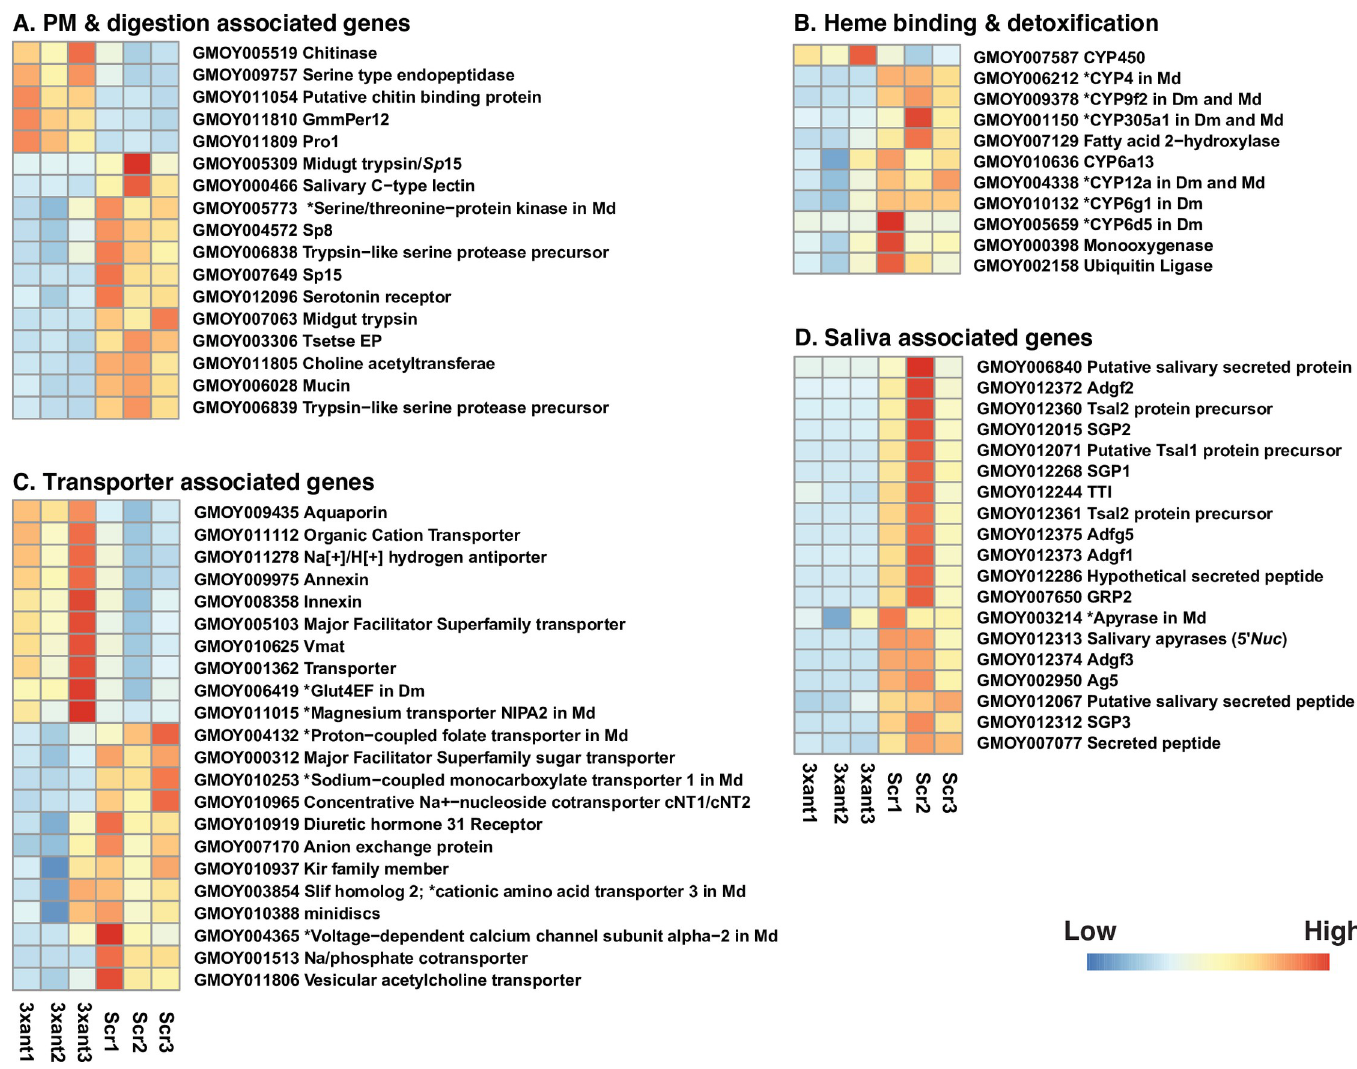
Fig 5. Heat map representation of DE genes in different functional groups (A-D) in paratransgenic cardia Gmm 3xant- miR275 vs. Gmm Scr-275 . (A) PM and digestion associated, (B) heme binding and detoxification, (C) transporter associated, and (D) saliva associated. Heat maps were generated by plotting the read counts in treatment (3xant- miR275 ) and control (Scr-275) samples. Colors display normalized gene expression values from low (blue) to high (red). � indicates the unknown gene product’s orthologue in Drosophila melanogaster ( Dm ) and/or Musca domestica ( Md)